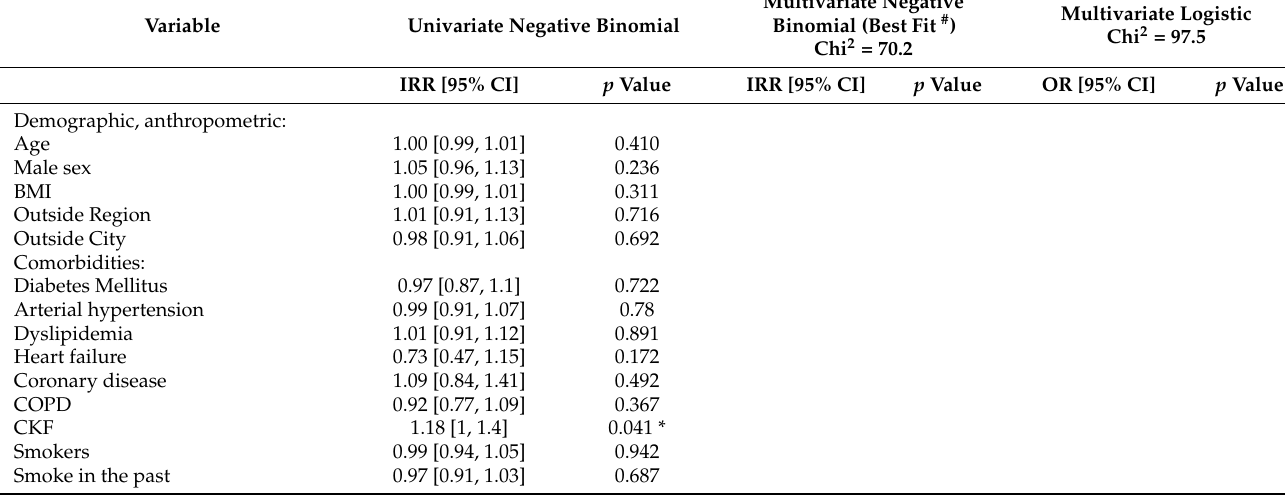
Table 4. Regression